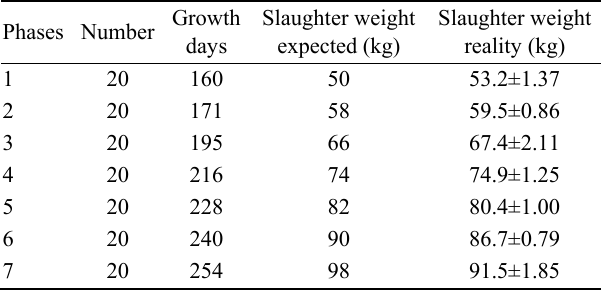
Table 2. Information of Liangshan pigs being